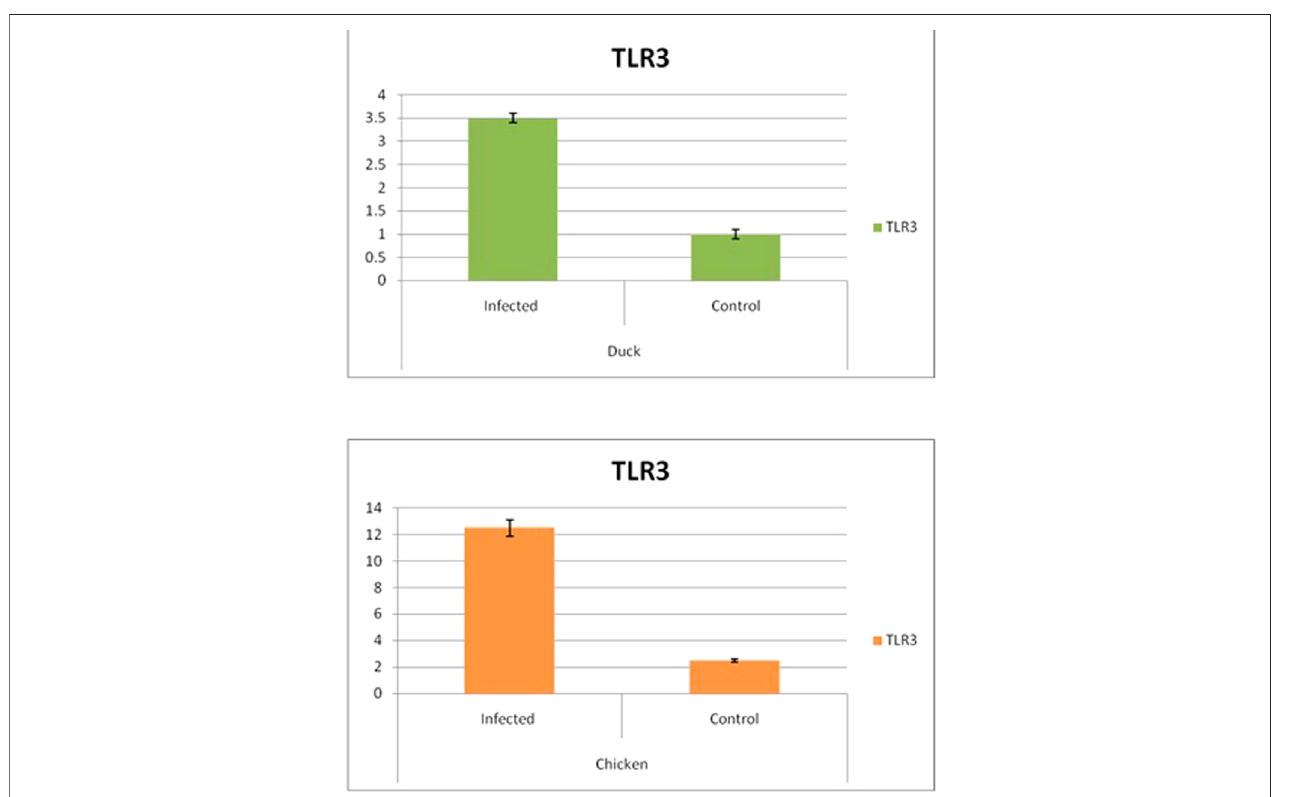
FIGURE 13 | Differential mRNA expression pro fi ling for TLR3 with respect to infected versus control Bengal duck and HB Chicken.